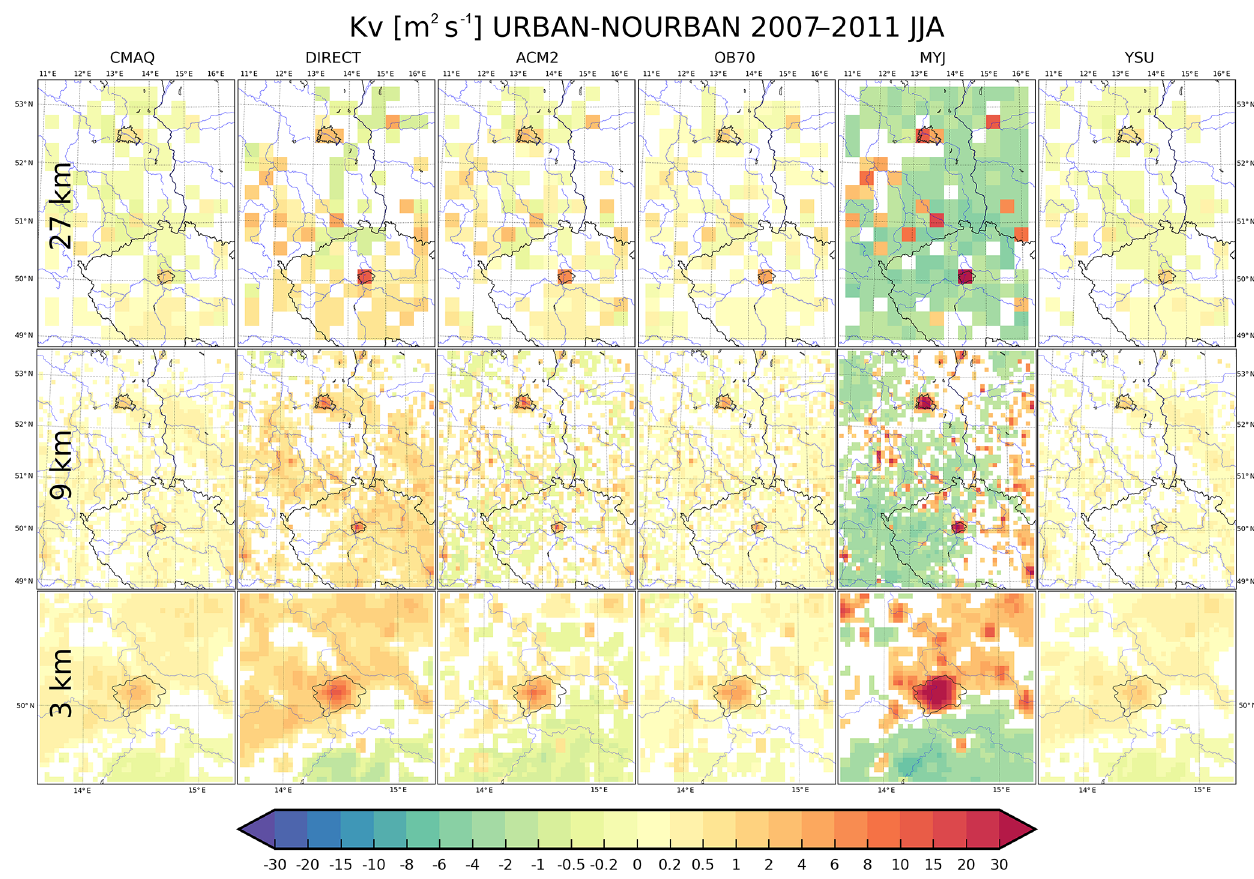
Figure 13. Impact of urban surfaces on the vertical eddy diffusion coefficient at 65m in m 2 s − 1 for the 27km (upper), 9km (middle) and 3km (lower row) for each K v method (CMAQ, DIRECT, ACM2, OB70, MYJ and YSU, from left to right). Shaded areas represent statistically significant changes over the 98% threshold using a two-tailed t test. The geographic locations of Berlin and Prague are indicated by their administrative